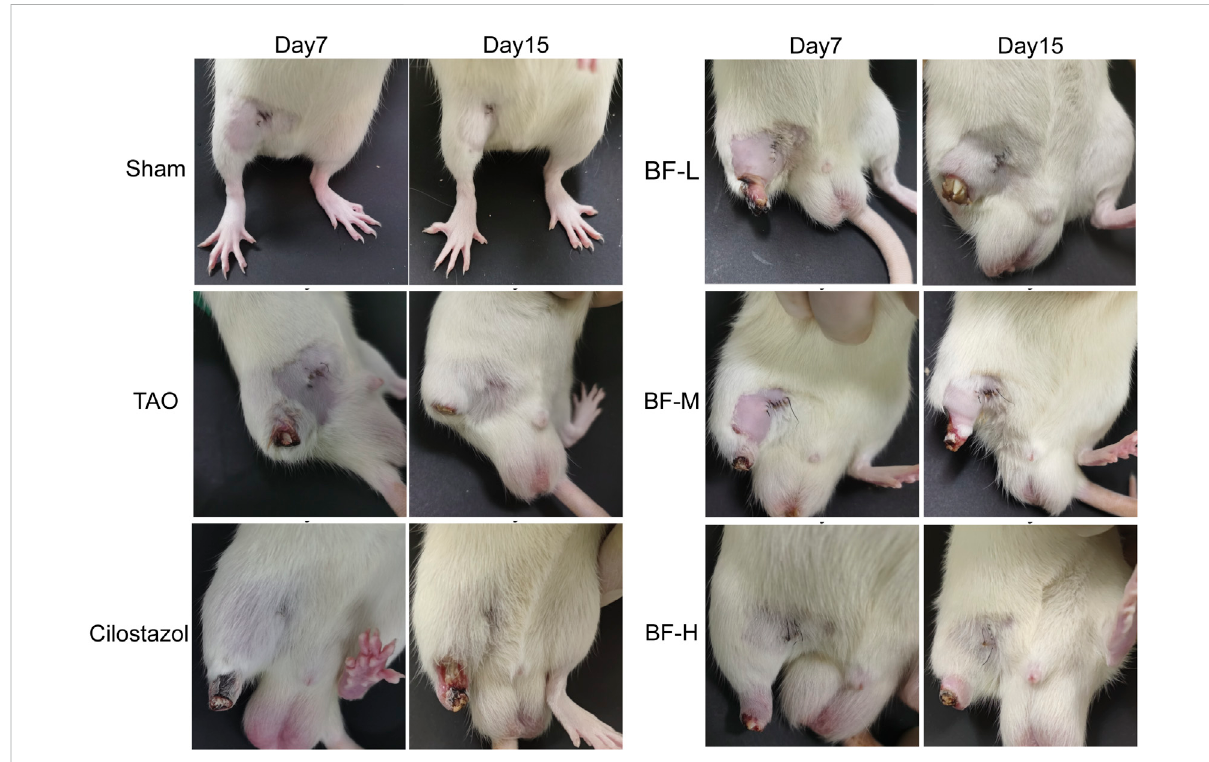
FIGURE 3 Appearance of the right hind limbs of rats. Sham: sham-operated group; TAO: TAO model group; Cilostazol: cilostazol group; BF-L: BF low- dose group; BF-M: BF medium-dose group; BF-H: BF high-dose